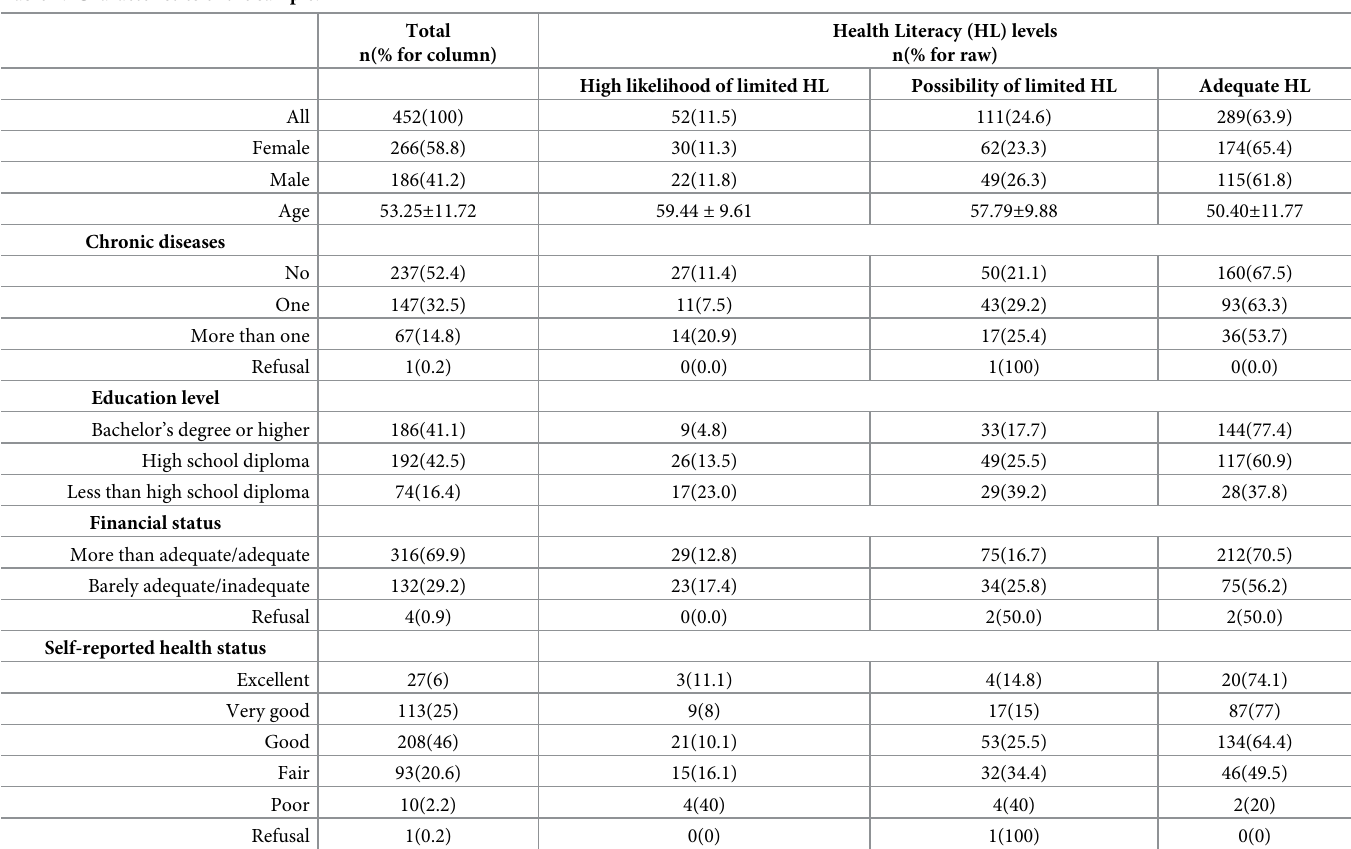
Table 1. Characteristics of the